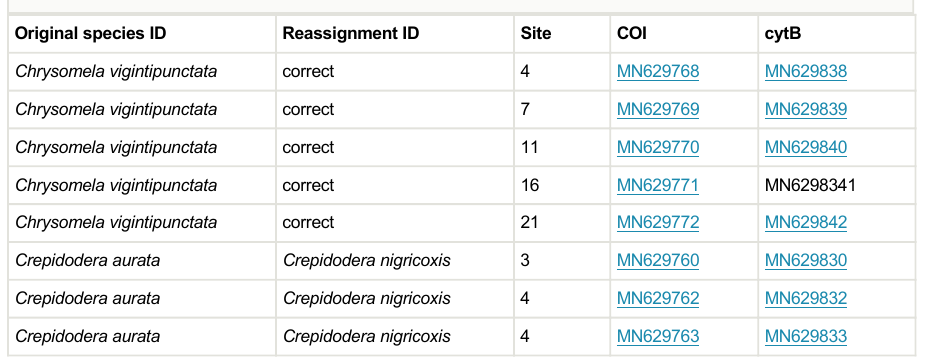
Samples sequenced in this study, reassignments made, and sequences deposited in GenBank: COI (cytochrome oxidase 1), cytB (cytochrome